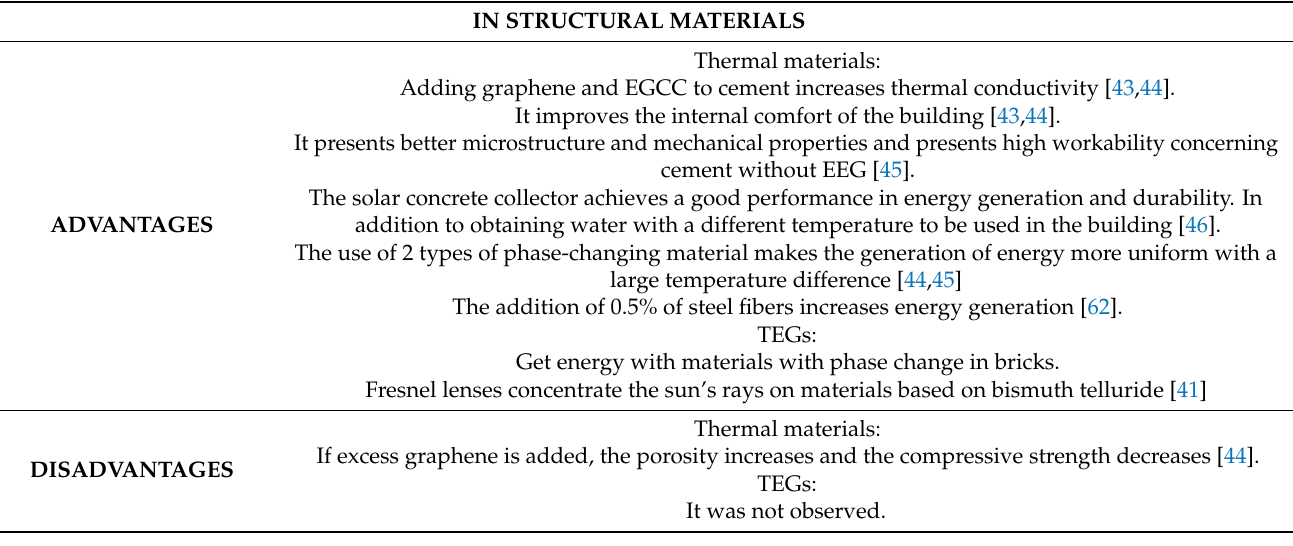
Table 3. Advantages and disadvantages in structural materials.